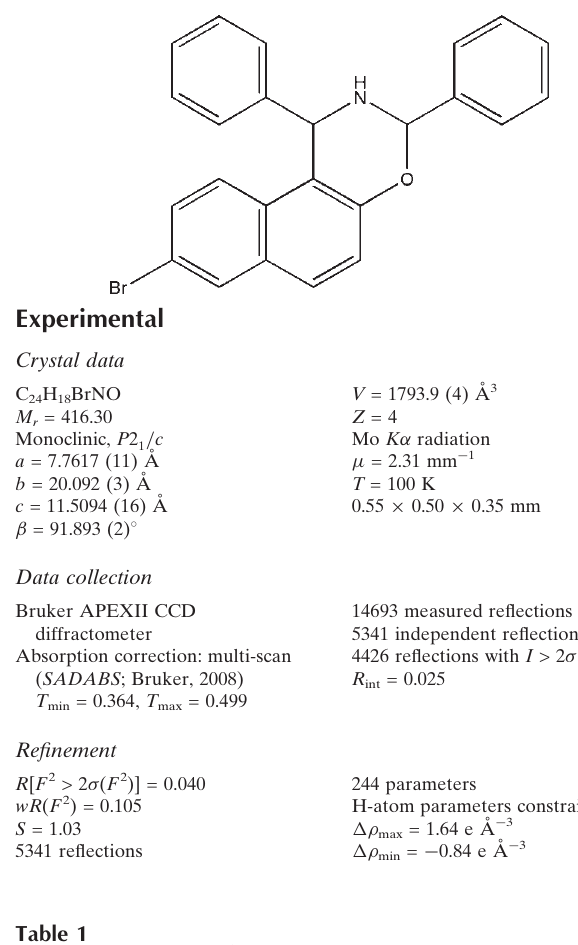
C—H (cid:3)(cid:3)(cid:3) (cid:3) interactions (A˚